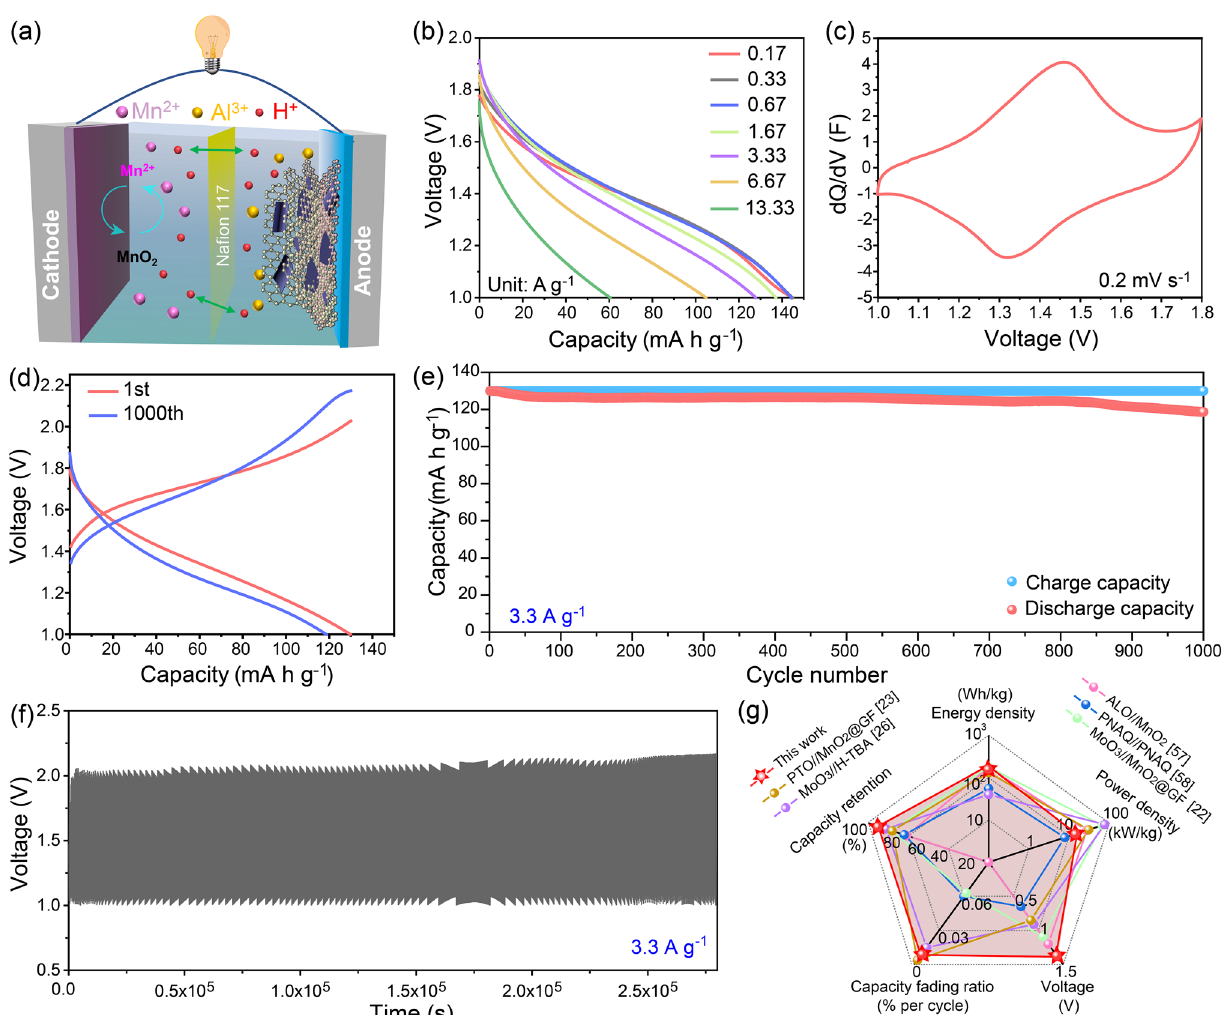
Fig. 5 Full-cell performances. The battery was assembled with Al-MoO x as the anode and the commonly used MnO 2 as the cathode. a Sche- matic illustration of battery assembly and the corresponding energy storage process. b Discharge profiles at different current densities. c The associated differential capacity curve at 0.2 mV s −1 . d GCD profile comparison at the 1st and the 1000th cycles. e Cycling performance at 3.3 A g −1 . f Voltage–time curve after 1000 cycles. g Performance comparison between this work and reported studies with radar chart including energy density, power density, voltage, capacity fading ratio and capacity